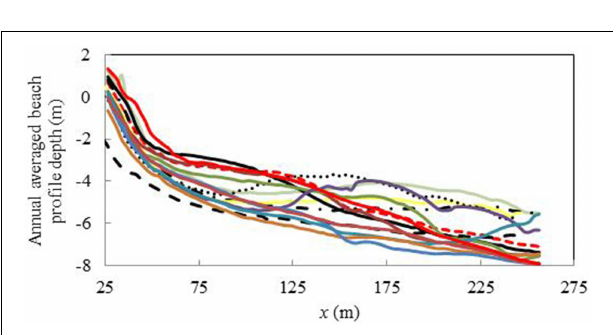
FIGURE 4 | Monthly averaged significant wave height derived from wave measurements carried out between 2001 and 2005.